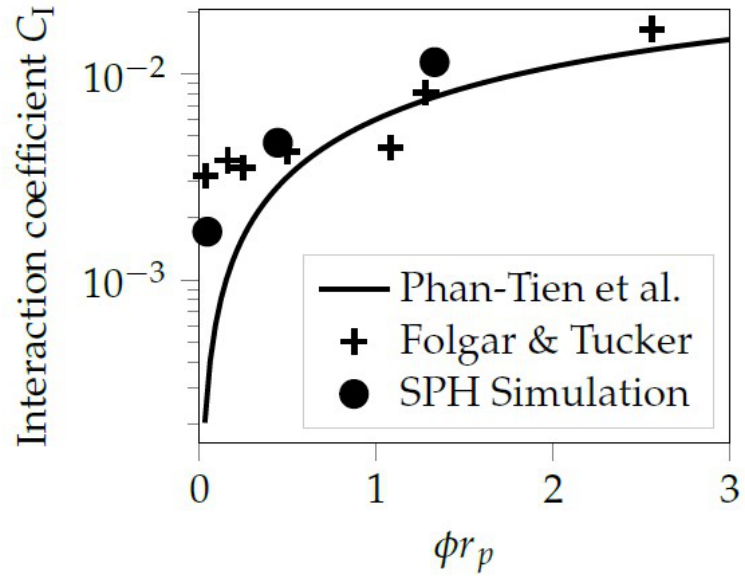
Figure 9. Comparison of C I values to the original work of Folgar and Tucker [4] and a fit based on simulation results by Phan-Tien et al. [47]. The values obtained in the presented work are reasonably close to these literature